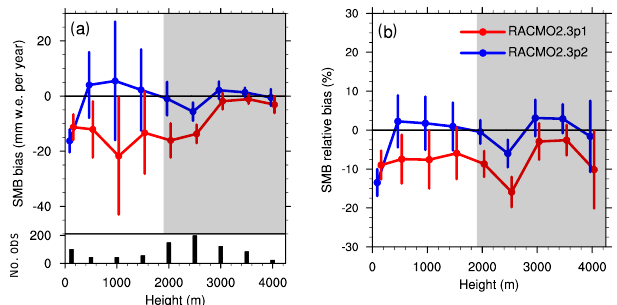
Figure 8. (a) Absolute bias and (b) relative bias ((model − observation) / model × 100%) in modelled SMB for RACMO2.3p2 (blue) and RACMO2.3p1 (red). The data are binned in 500m sur- face elevation intervals (0–250, 250–750, etc.). Error bars denote the combined uncertainty of the model and observations within each height bin, based on Van de Berg et al. (2006) and Van Wessem et al. (2014a). Elevations above 2000m (shaded grey) represent East Antarctica exclusively. The bar chart in (a) denotes the number of weighted observations in each bin. To separate blue and red lines, x axis locations of each bin are displaced by